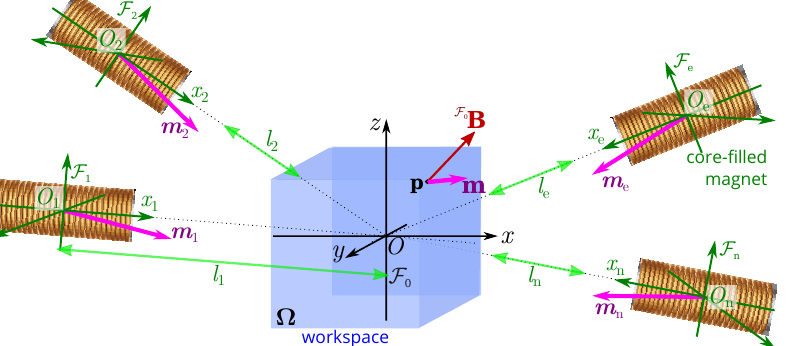
Figure 4. Representation of the multipole-electromagnet system to induce a magnetic field B ( p ) in the workspace Ω (blue square box). The length l e denotes the distance between the coil center O e and the workspace center O